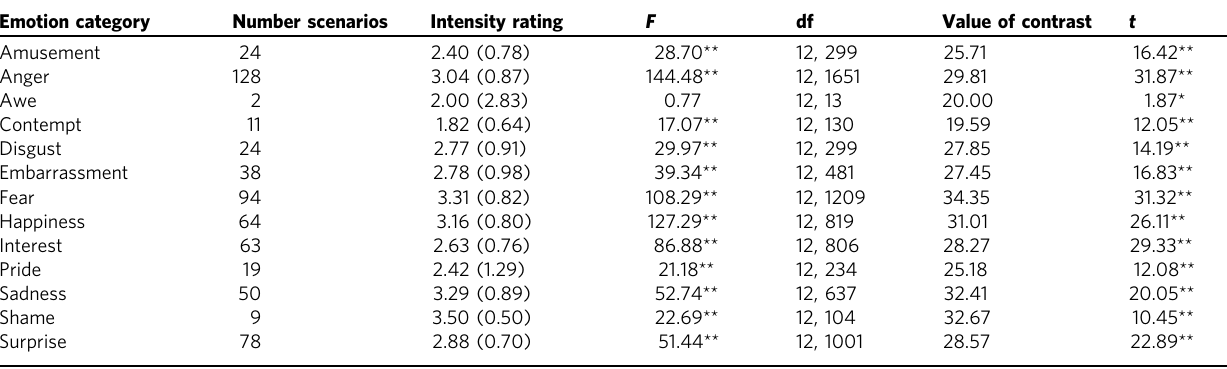
Table 1 Scenarios assigned to emotion